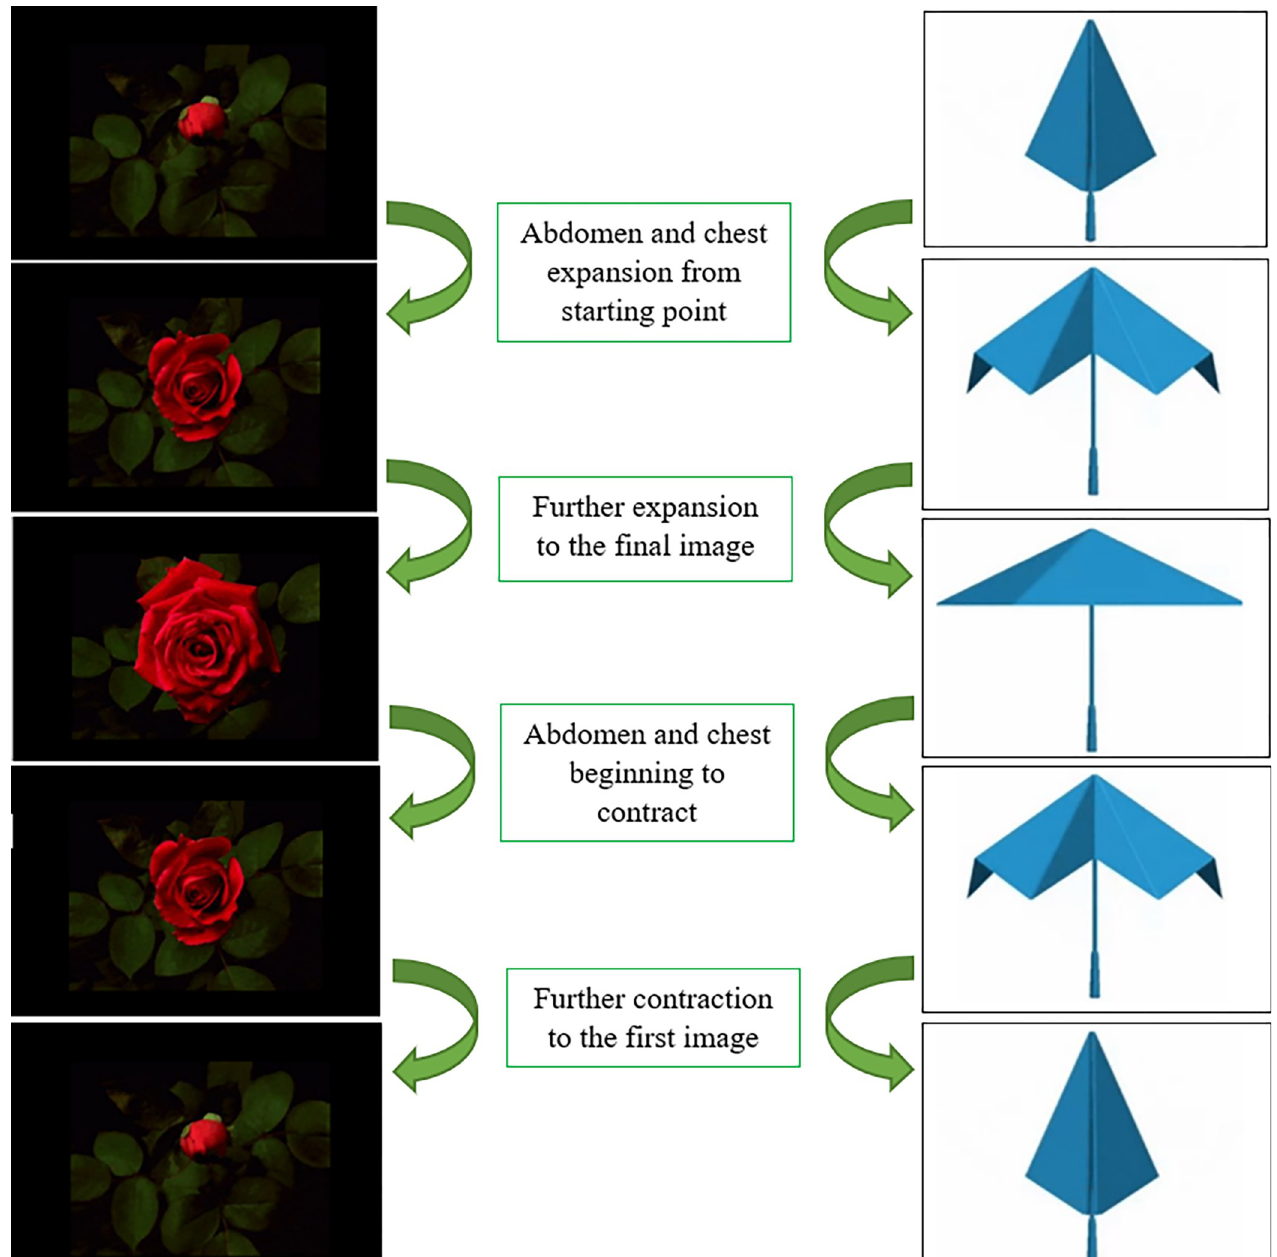
Fig 2. Visual representation of the abdomen and chest animations. The abdomen is represented by the rose and the chest is represented by the umbrella with each being independently controlled by the respective RIP belt. A change in the circumference of a belt results in a change in the voltage being output by the belt. The animations were programmed to change images based on these changes in voltage outputs. The actual animations contained 194 images for the rose and 156 images for the umbrella over the range of possible